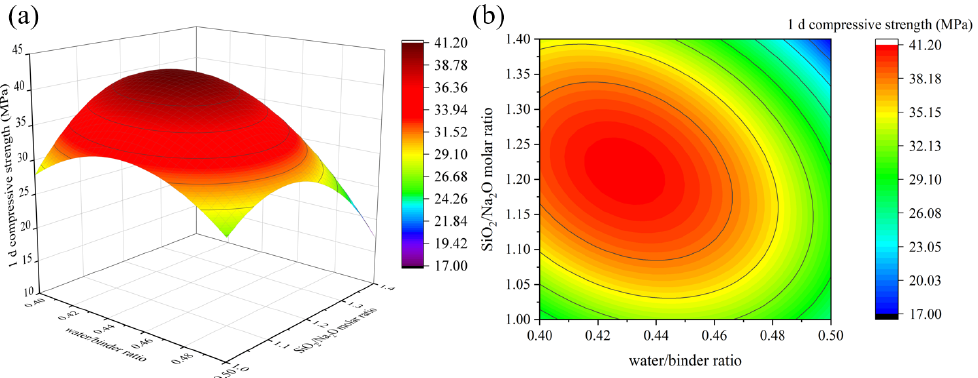
Figure 7 . The interaction effect of water/binder ratio and GGBS content on 1 d compressive strength: ( a ) 3D response surface; ( b ) contour diagram.